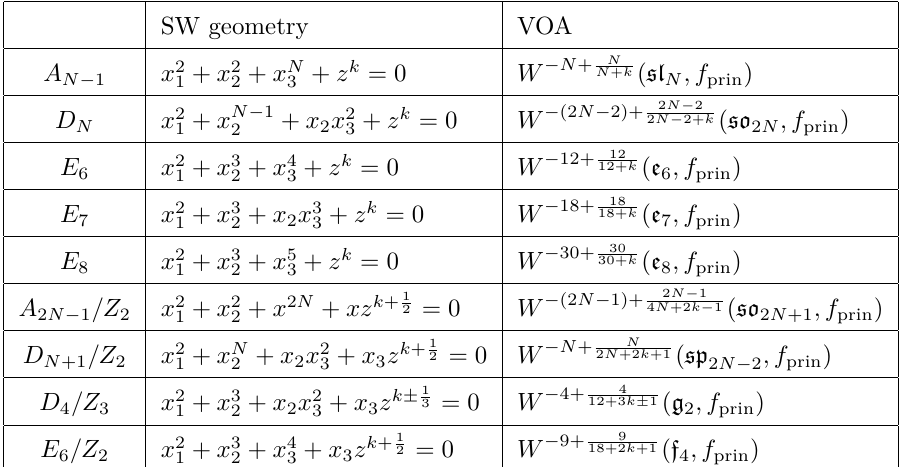
Table 11 . 4d SCFTs whose VOA is admissible lisse W-algebra. Here k is constrained so that 4d theory has no mass deformation and the level of W-algebra is admissible. Namely, ( k, h ∨ ) = 1 for ADE case, (2 k +1 , h ∨ ) = 1 for BCF case, and finally (3 k ± 1 , h ∨ ) = 1 for G field theory has no exact marginal